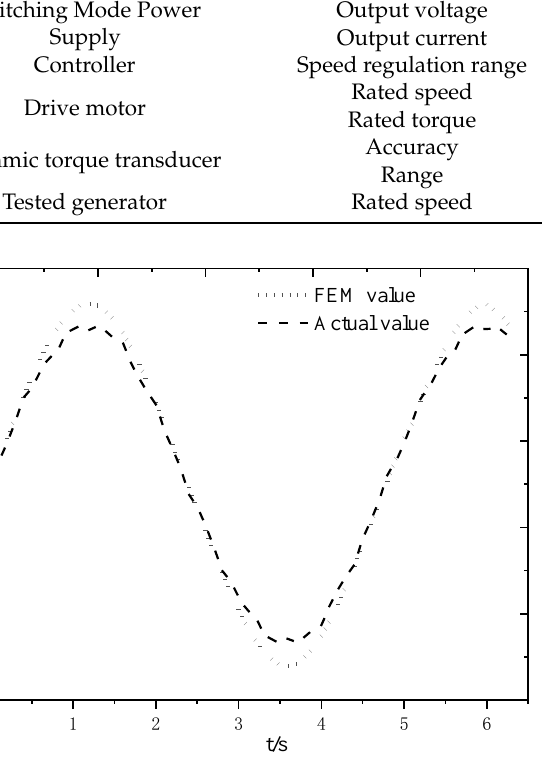
Figure 12. FEM versus Actual EMF.